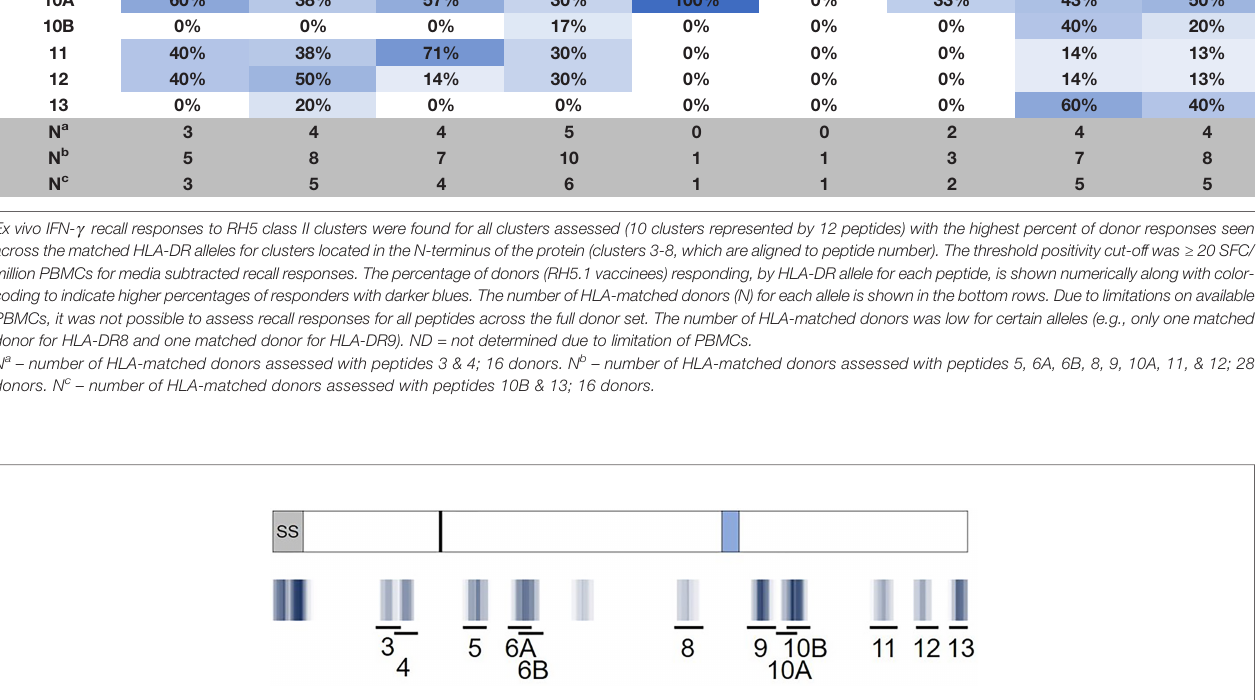
FIGURE 5 | Predicted RH5 class II clusters (blue) aligned to the RH5 peptide set (black lines) assessed for in vitro HLA binding and ex vivo T cell IFN- g recall responses. A visual representation of the epitope density of thirteen predicted class II epitope clusters for RH5 is provided and aligned to the RH5 peptide set (10 clusters represented by 12 peptides). The RH5 protein sequence and an overlay of key protein features are depicted in the top box. The signal sequence (SS, grey box), approximate proteolytic processing site at aa 127 (black line), and the loop separating the N- and C-terminal regions of the protein (light blue box) are shown. Darker blue hues denote clusters with higher epitope density, measured by number of EpiMatrix hits, while white areas denote no EpiMatrix hits. The speci fi c locations of the twelve peptides tested are also shown. Note that the amino acid coordinates for the clusters corresponding to the peptides with the highest VAC063 donor responses, and that were also assessed with VAC057 donors, are as follows: peptide 3: 79-97; peptide 4: 92-110; and peptide 6A: 179-205.